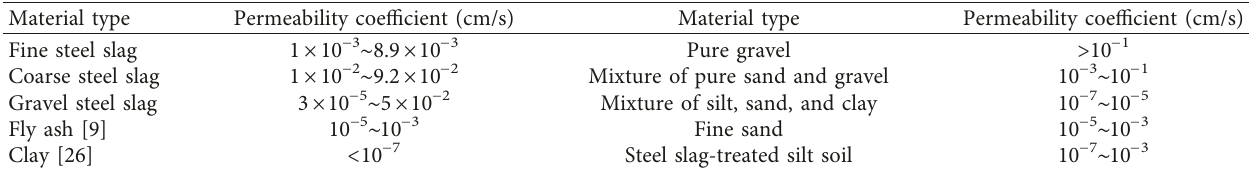
Figure 11: Fitting curves on the permeability coefficient of steel slag-treated silt soil. Table 10: Permeability coefficients of steel slag and traditional